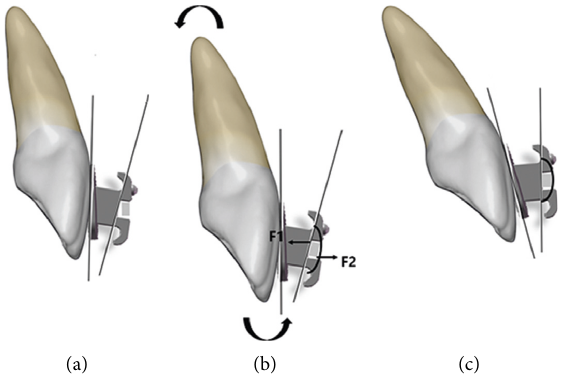
Figure 2: Schematic of the torsion application system. Sagittal view of new ribbonwise bracket during its realization of “ligation torque expression.” (a) No torque will be transmitted when any archwires are placed vertically in the 0.030 ″ × 0.022 ″ slot since the slot is much larger. (b) The steel ligatures were tightened as tight as possible thus the archwire was securely pressed onto the slot bottom. (c) Torque will be derived from the contact of the slot bottom and the ligature wire, then torque will be expressed in the arrow